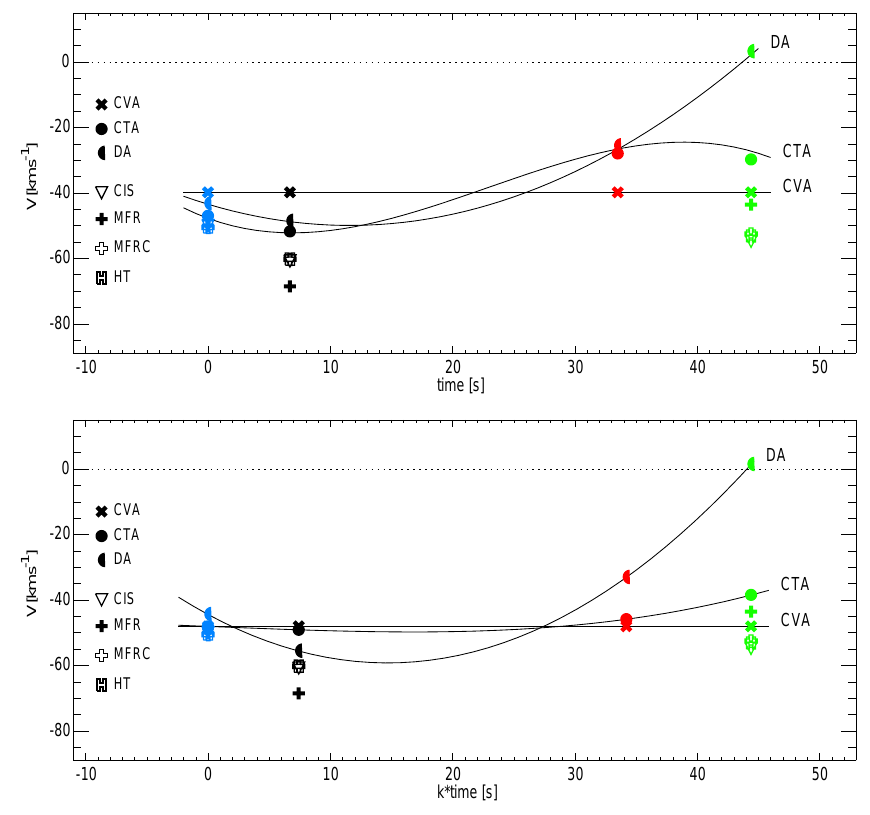
Fig. 3. Magnetopause velocity curves, derived from multi-spacecraft timing in Fig. 2, using the constant velocity approach (CVA), the constant thickness approach (CTA), and the discontinuity analyzer approach (DA). Curves in the upper panel are based on FGM timing; those in the lower panel are based on EFW timing and are shown on a stretched time scale ( k ∗ time ) to facilitate comparison with FGM curves. The filled symbols are predicted average velocities during each crossing duration (2 τ ): filled crosses=CVA; filled circles=CTA; filled semicircles=DA. Velocities predicted from single-spacecraft methods, based on prime-parameter data, are shown for comparison: CIS=three CIS measurements of normal plasma speed in middle of magnetopause; MFR and MFRC=results of unconstrained and constrained ( h B i· n = 0 ) Minimum Faraday Residue analysis; HT=normal component of deHoffmann-Teller velocity with normal from MVABC. Color code as in Fig.